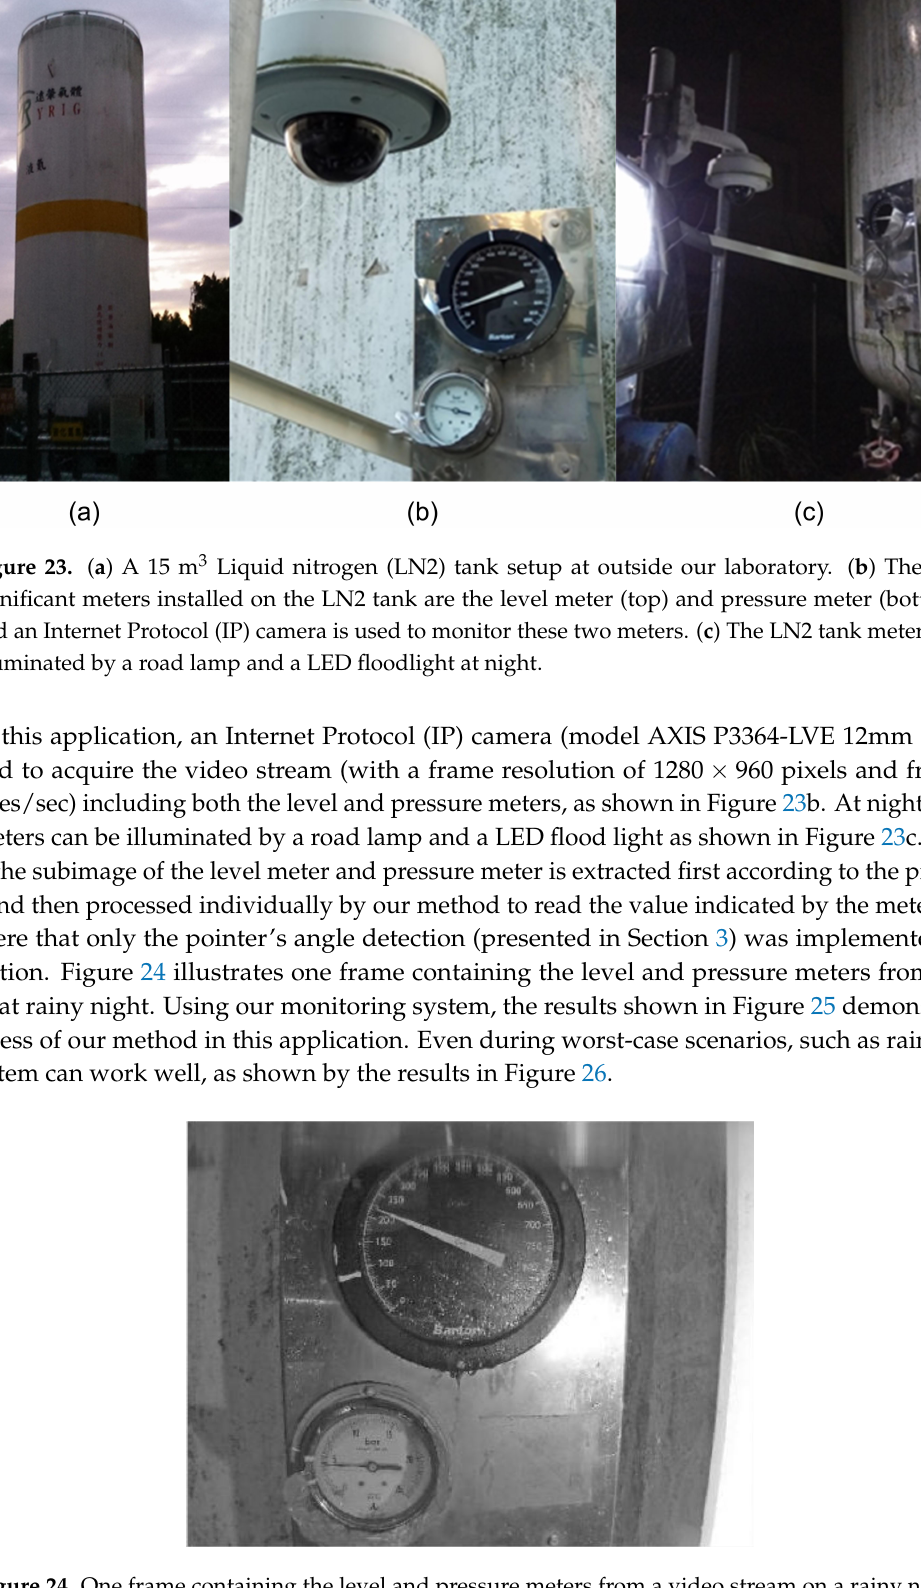
Figure 24. One frame containing the level and pressure meters from a video stream on a rainy